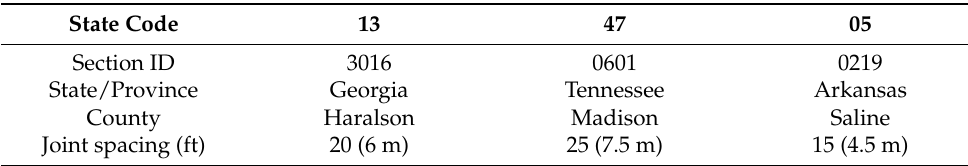
Table 1. The locations and joint spacings of selected projects.